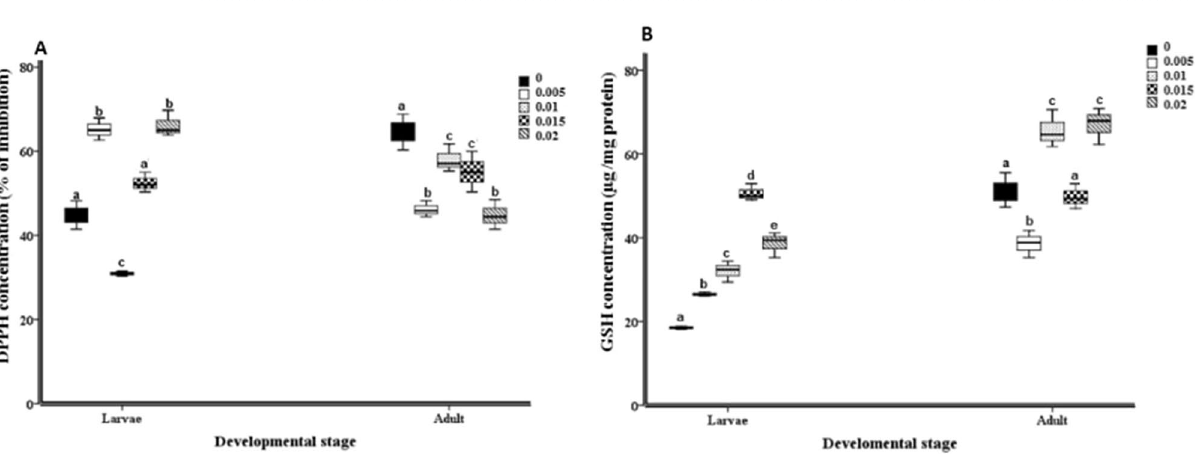
Figure 3. Activity of non-enzymatic response in form of the concentration of anti-radical 2,2-diphenyl-1- picrylhydrazyl (DPPH) (percentage of inhibition) ( A ), and antioxidant glutathione reduced (GSH) (µg/ mg protein) ( B ). The non-enzymatic antioxidants concentration was expressed, in a box-plot graph, as median, min., max., P25, and p75 values. The non- enzymatic antioxidant concentration obtained from gut homogenates of 5th instar larvae and males of Hermetia illucens , which their food containers were exposure different concentration of malathion (0, 0.005, 0.01, 0.015, 0.02 mg/ml). Mean values marked with the different lowercase letters were significantly different among malathion concentration assessment (ANOVA test Tukey’s-b , Post Hoc test, p <